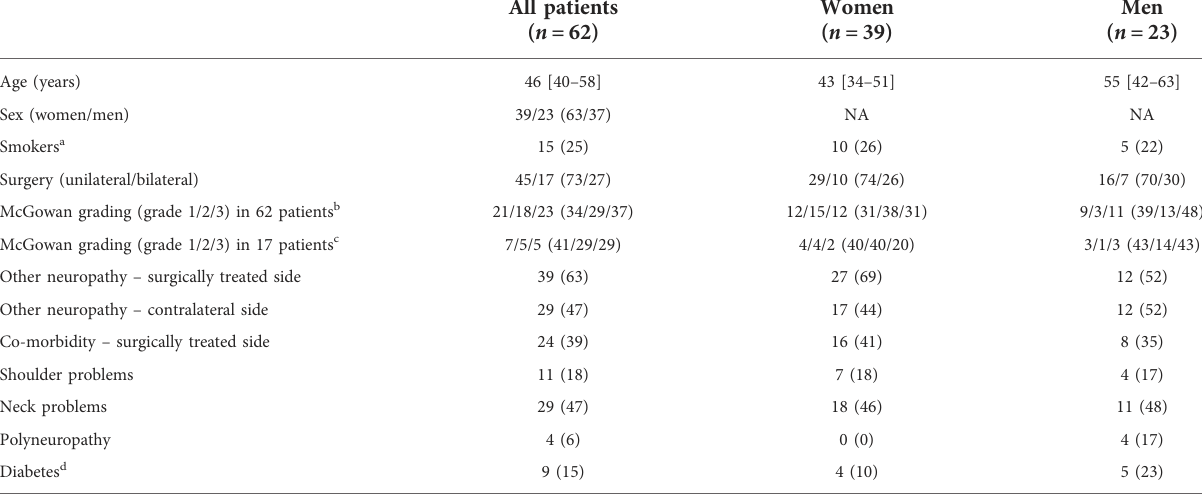
All patients ( n = 62)